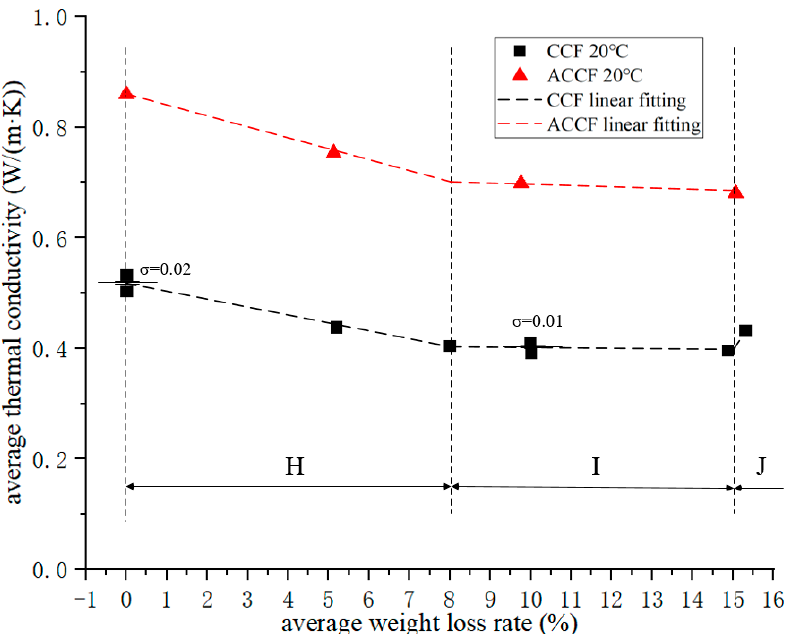
Figure 5. Average thermal conductivity–average weight loss rate curve.